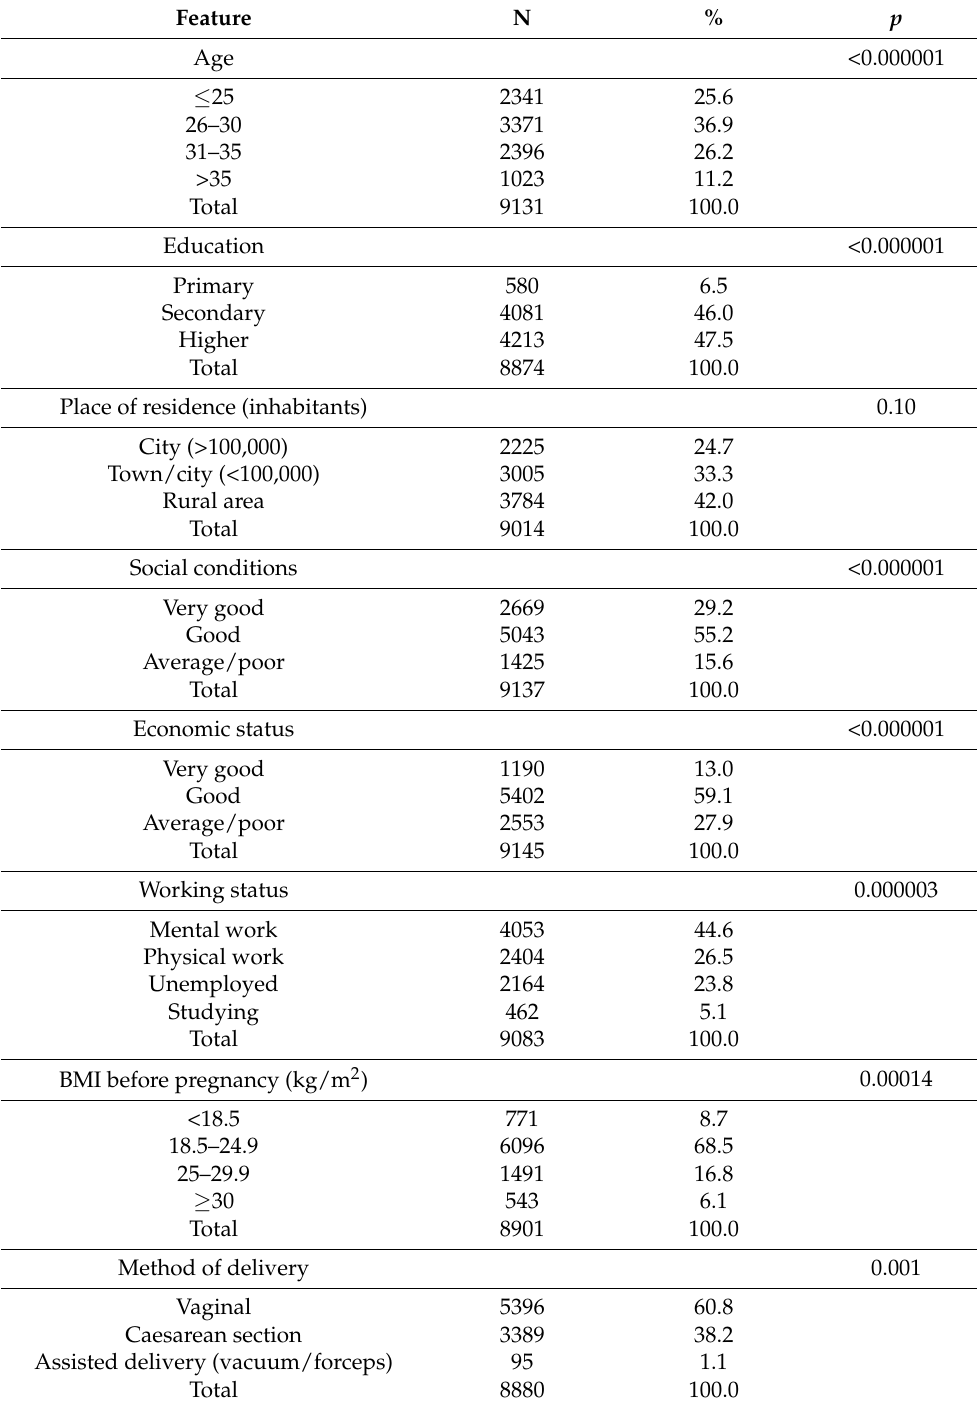
Table 1. Characteristics of the study